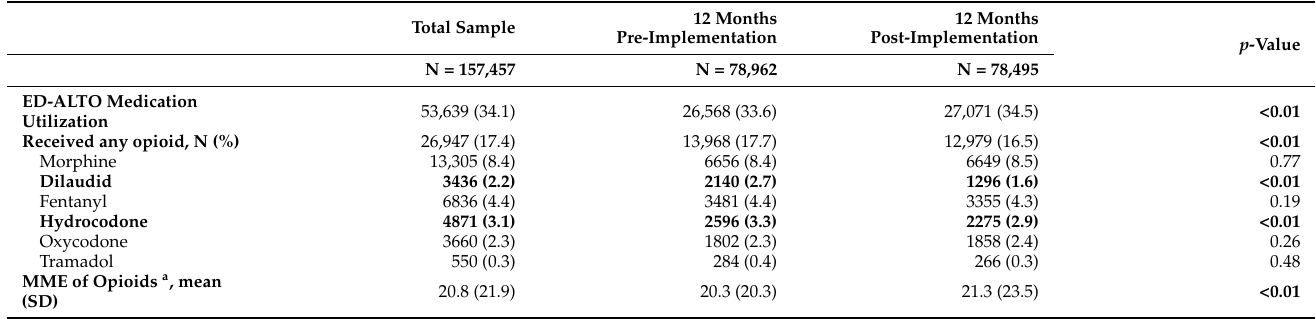
Table 2. ED-ALTO medication and opioid utilization pre-and